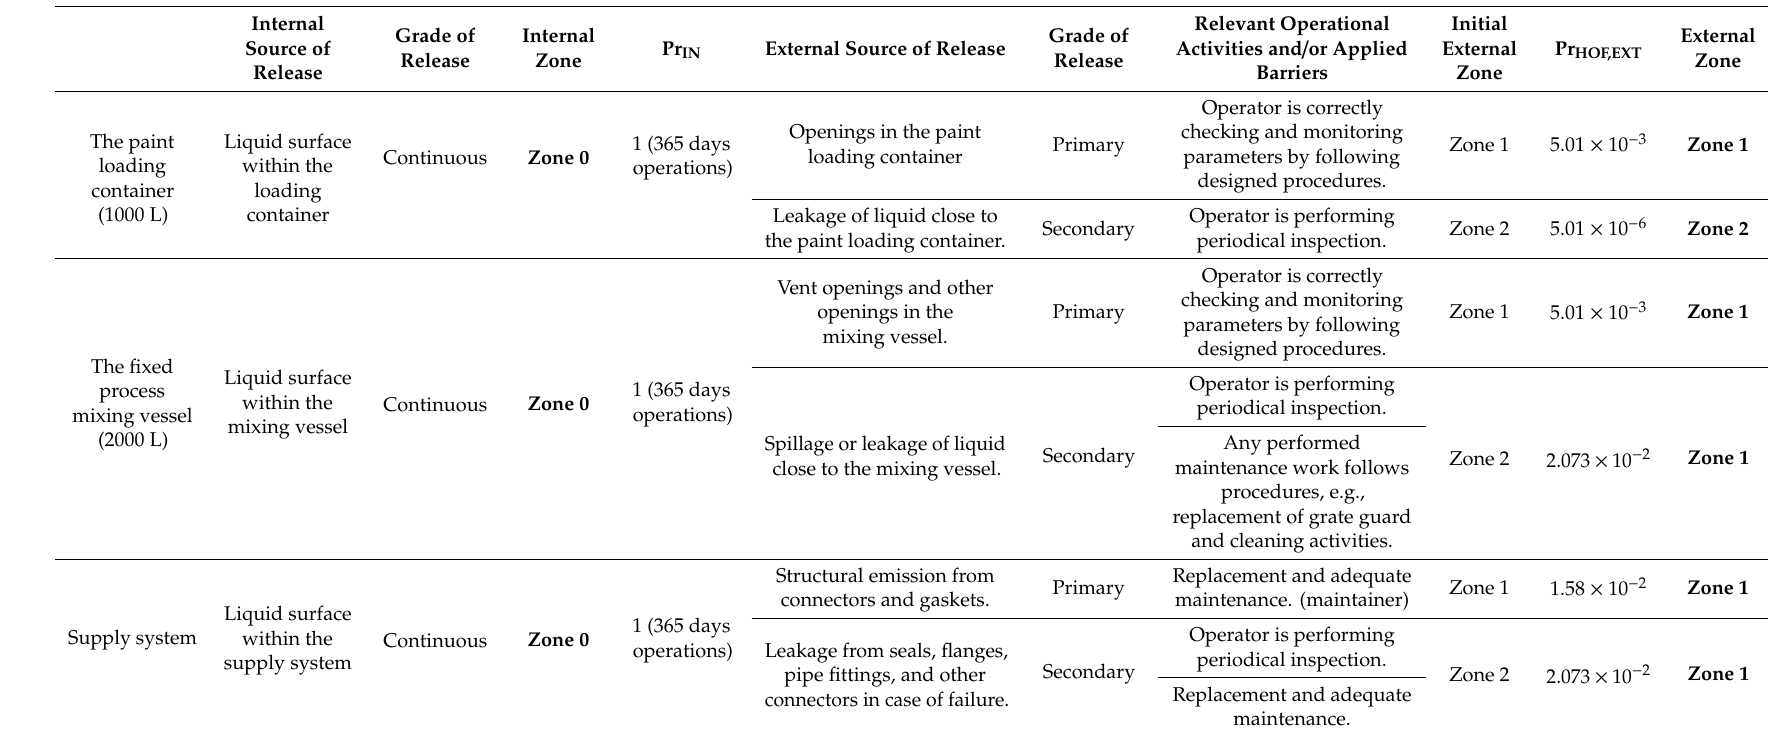
Table 14. Results of zone classification according to the ATEX-HOF